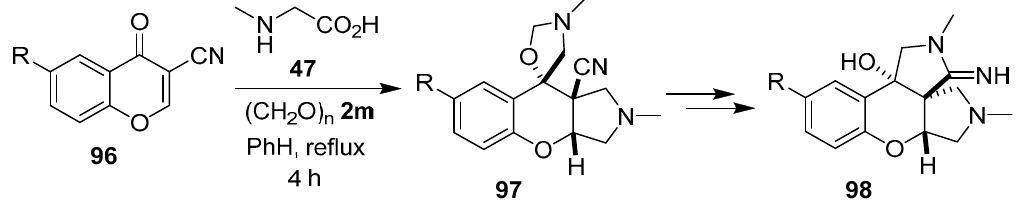
Oxazolidines 97 % Yield 1 quant. quant.